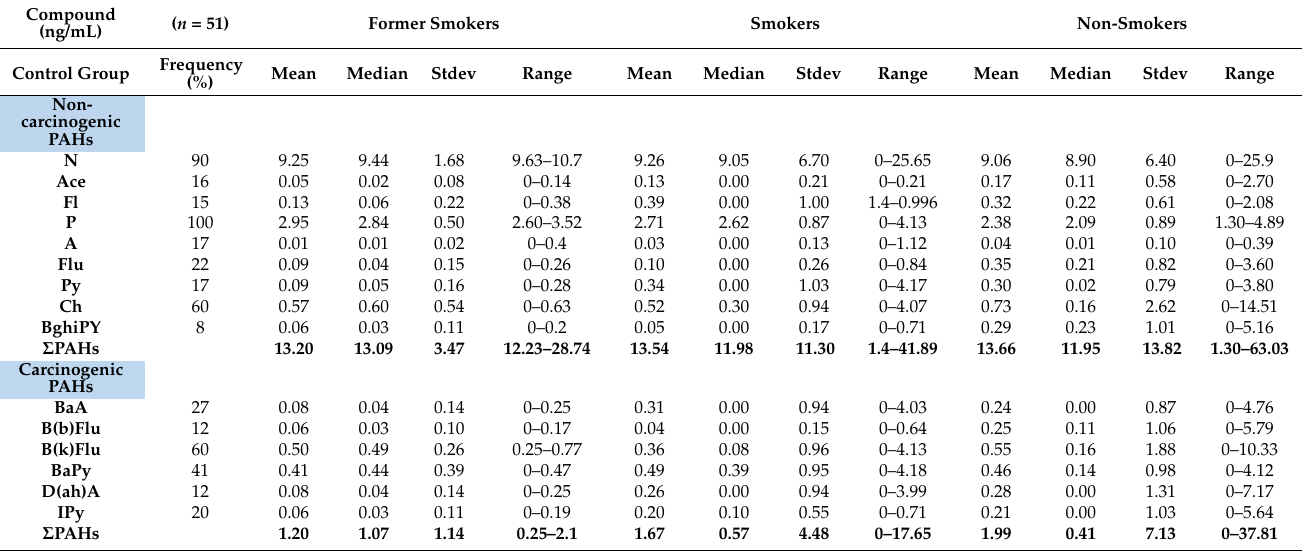
Table 2. PAHs concentrations (ng/mL) in human blood serum of patients selected for the control group.